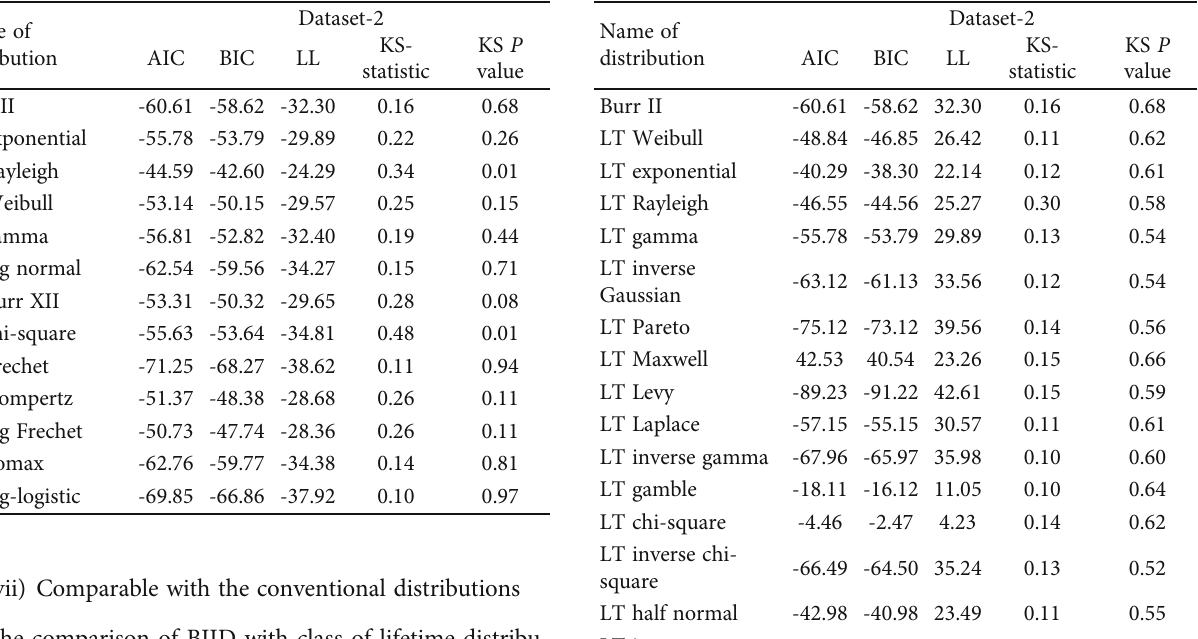
Table 25: Comparison of BT-IID with class of LTDs using